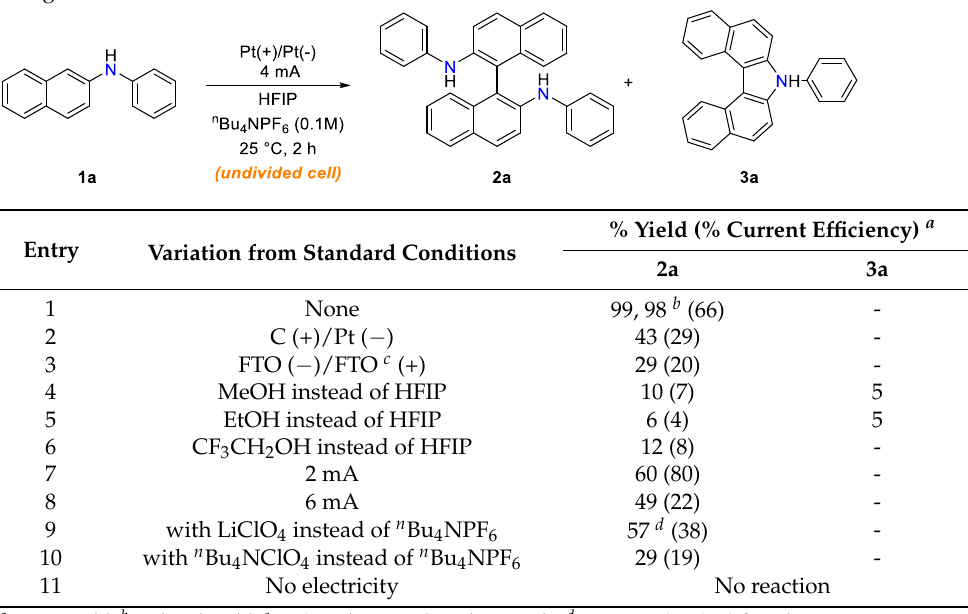
Table 1. Optimization of the conditions for the electrochemical homocoupling of 2-naphthylamines using 1a as the model substrate.